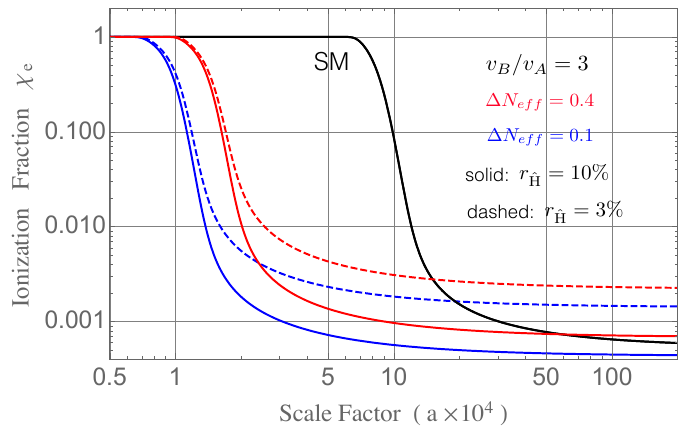
Figure 2 . The SM (blue) and Twin electron ionization fraction as a function of the scale factor. The MTH results are shown with di(cid:11)erent values of r ^H = (cid:10) ^H = (cid:10) DM